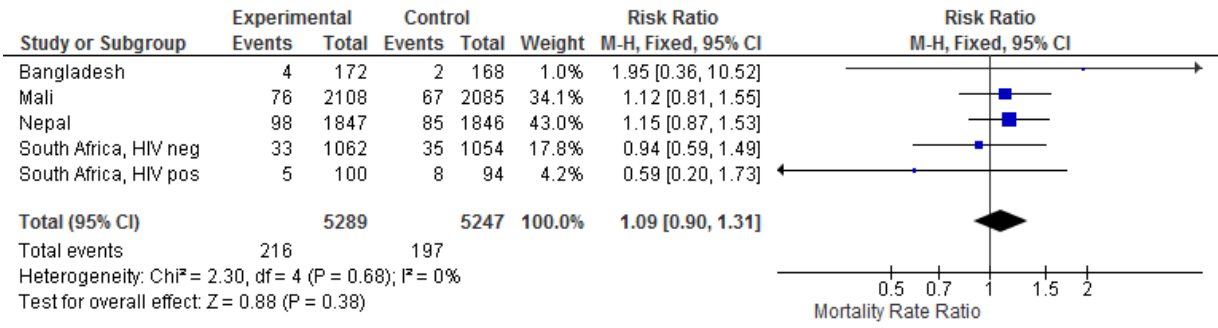
Figure 3. The effect of influenza vaccination in pregnancy on overall miscarriage/stillbirth/infant mortality.